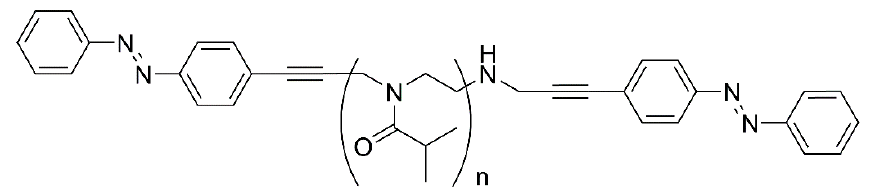
Figure 20. Thermo- and light-sensitive polymer based on